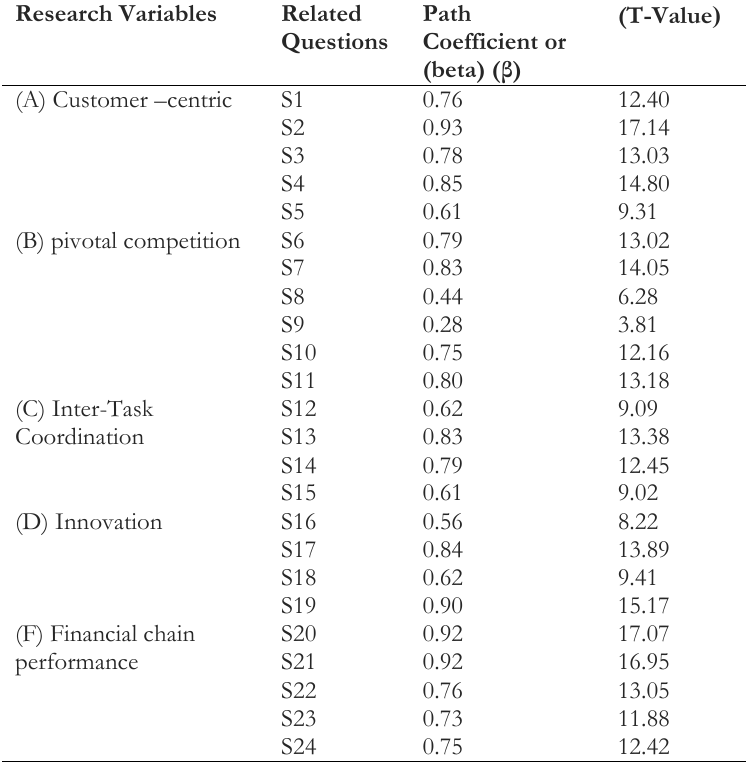
Table 5. Values of beta and T-Value of confirmatory factor analysis.